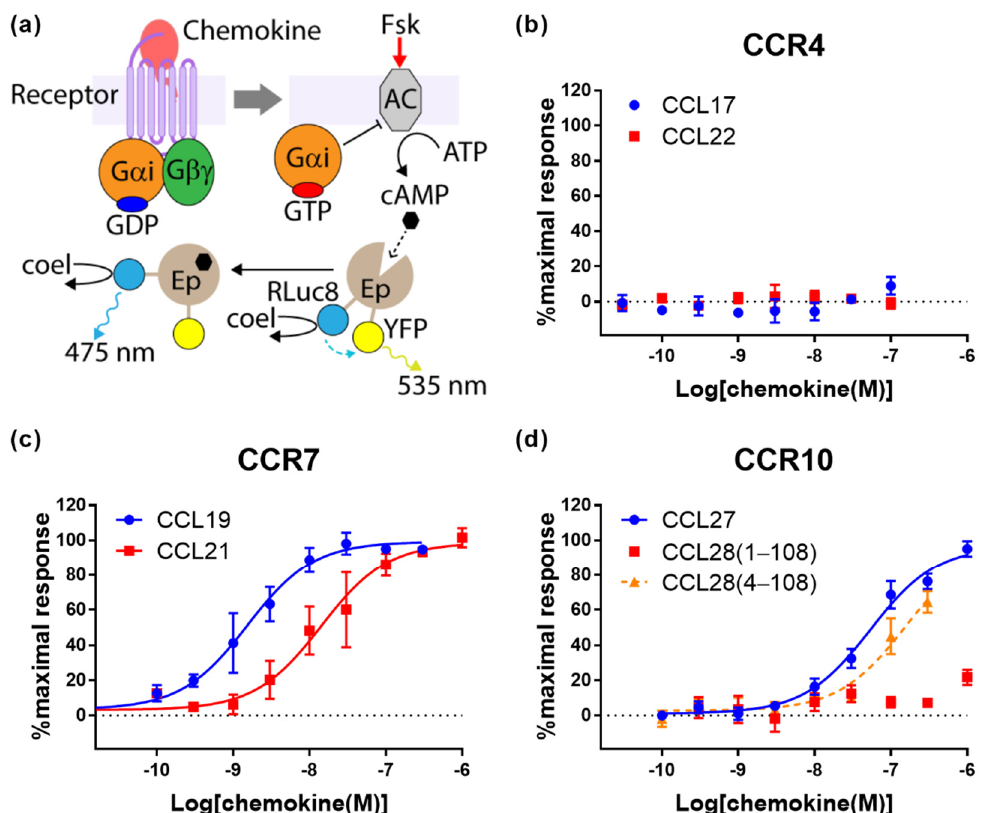
Figure 3. Chemokine ligands differentially inhibit cAMP synthesis via CCR4, CCR7 and CCR10. ( a ) The principle of the BRET-based cAMP assay. Upon activation of a chemokine receptor, the dissociated G α i/o proteins inhibit the activity of forskolin (Fsk)-stimulated adenylyl cyclase (AC), thus reducing the intracellular concentration of cAMP. The cAMP biosensor CAMYEL is composed of the cAMP binding protein Epac1 (Ep), tagged at opposite ends with RLuc8 and the YFP variant Venus. The conformation of Epac1, within CAMYEL, changes upon binding cAMP and this is used to monitor cellular levels of cAMP by the change of BRET signals. ( b – d ) Chemokine-induced inhibition of cAMP production via ( b ) CCR4 ( c ) CCR7 ( d ) CCR10. A dashed line of best fit is shown in the case that the signal does not reach saturation. The presented data are mean ± SEM of at least three independent experiments, each performed in triplicate. Table 2. Expression levels (%) of chemokine receptors CCR4, CCR7 and CCR10 in CHO cells 1 . Receptor Normalized Expression Level